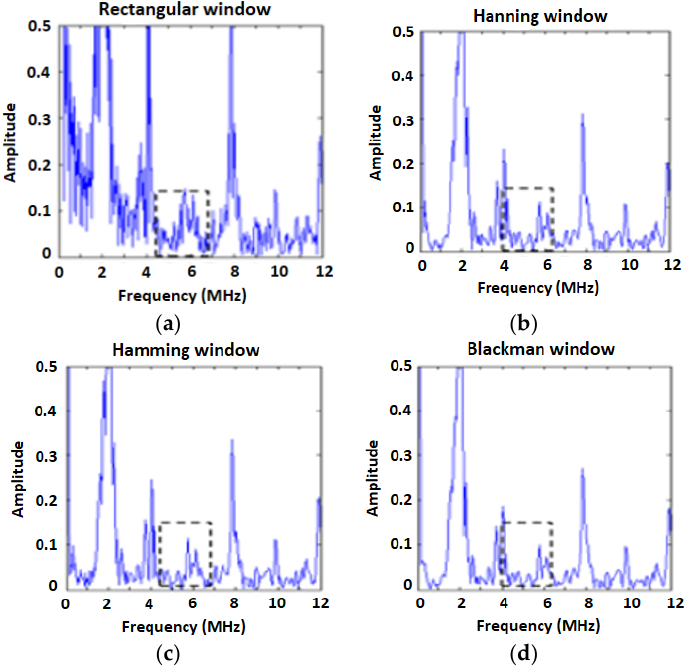
Figure 11. FFT results: ( a ) Rectangular window; ( b ) Hanning window; ( c ) Hanmming window; ( d ) Blackman window.